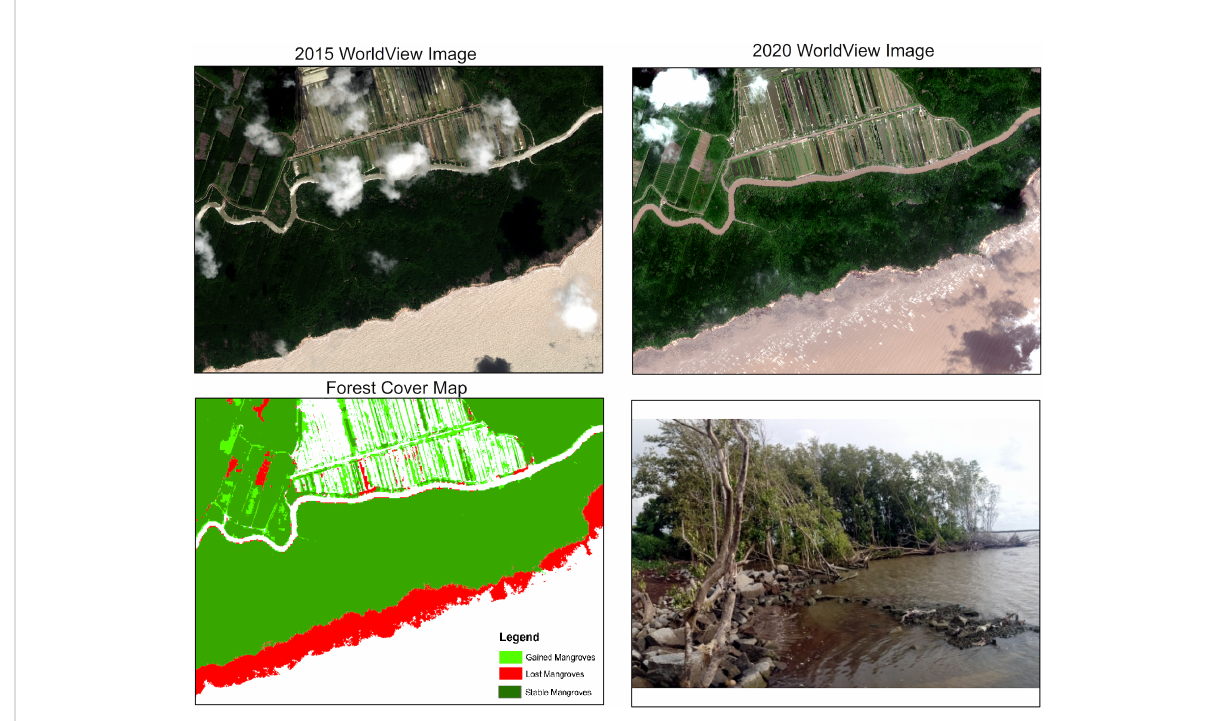
FIGURE 5 Mangrove squeeze that results from coastal erosion and inland barriers that prevent mangrove migration.